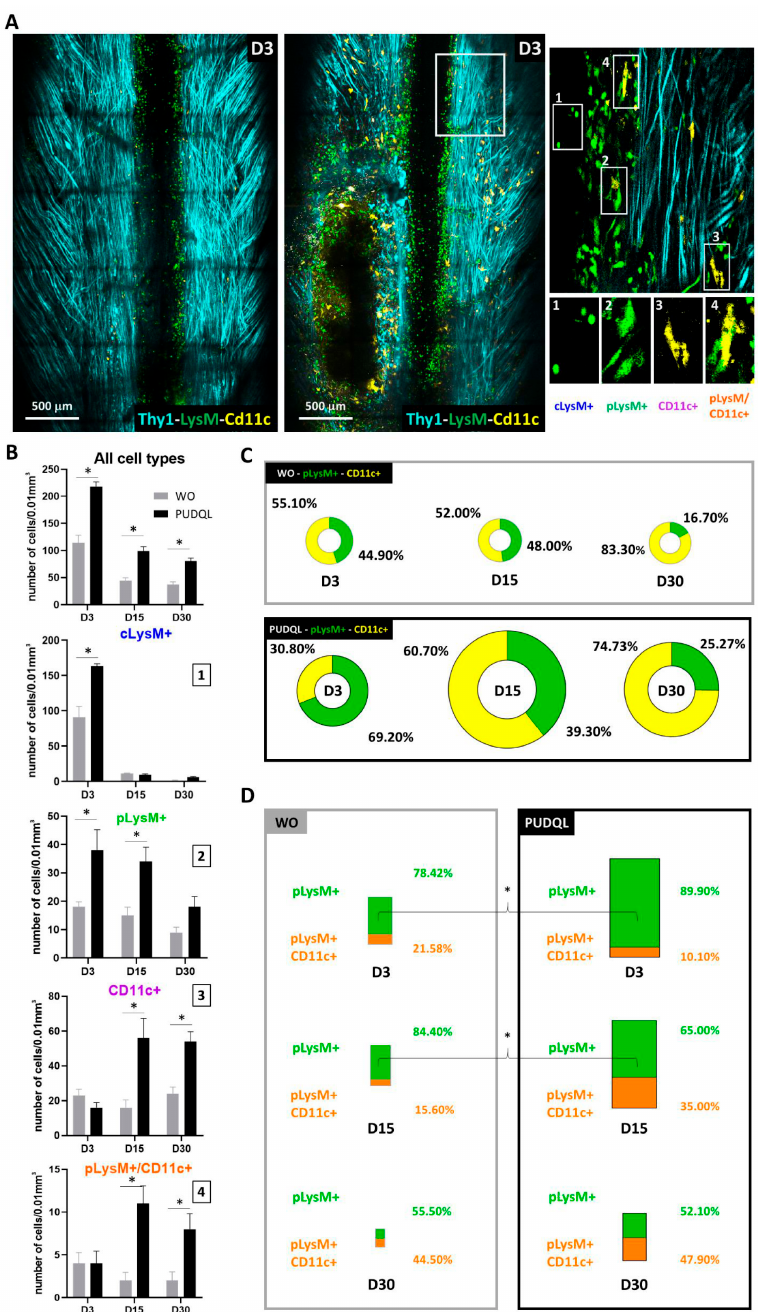
Figure 5. Characterisation of immune cells response after PUDQL in triple fluorescent mice. ( A ) Rep- resentative maximal intensity projection of 2P images obtained in vivo three days (D3) after PUDQL or window implantation only (WO). Note the massive axonal degeneration (dark area) underlined by immune cell accumulation following PUDQL (bottom left corner) in comparison to a contralateral area (top right white square). High magnification image of the white square showing the four identified cell types. ( B ) Quantitative evolution of global fluorescent cells densities (top) or individual subsets (1–4) in PUDQL (n = 5) and WO (n = 3) animals. Data are shown as mean ± SEM. ( C ) Circular graphs showing the relative percentage of pLysM+ and CD11c+ cells 3, 15 and 30 days after window implantation with or without PUDQL. Diameter of the circles is proportional to the total number of pLysM+ and CD11c+ cells densities quantified at each time point. ( D ) Bar graphs showing the relative percentage of pLysM+/CD11c+ cells among pLysM+ cells 3, 15 and 30 days after window implantation with or without PUDQL. Height of the bar is proportional to the total number pLysM+ and pLysM+/CD11c+. * p <